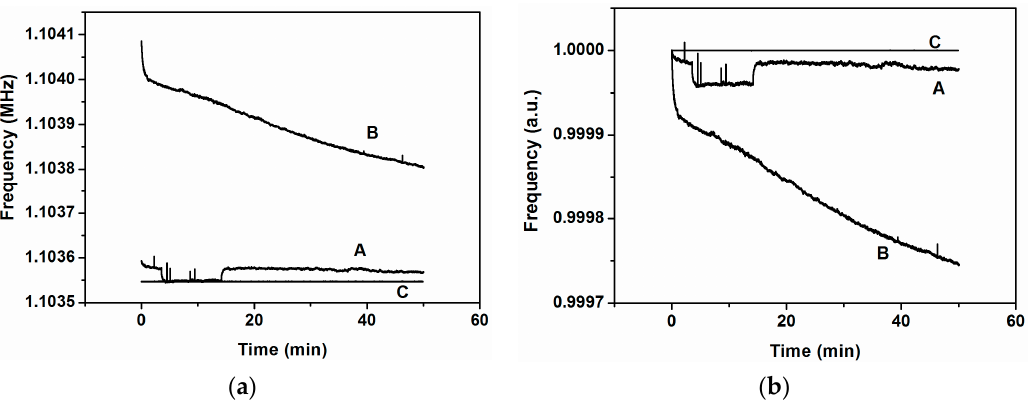
Figure 9. ( a ) Closed-loop frequency for stimulus at cantilever number 2 for different frequencies: A , at 1.04 MHz; B , at 1.06 MHz; C , at 1.103552 MHz; ( b ) Scaled frequencies by the starting point for the same cases than in ( a ).